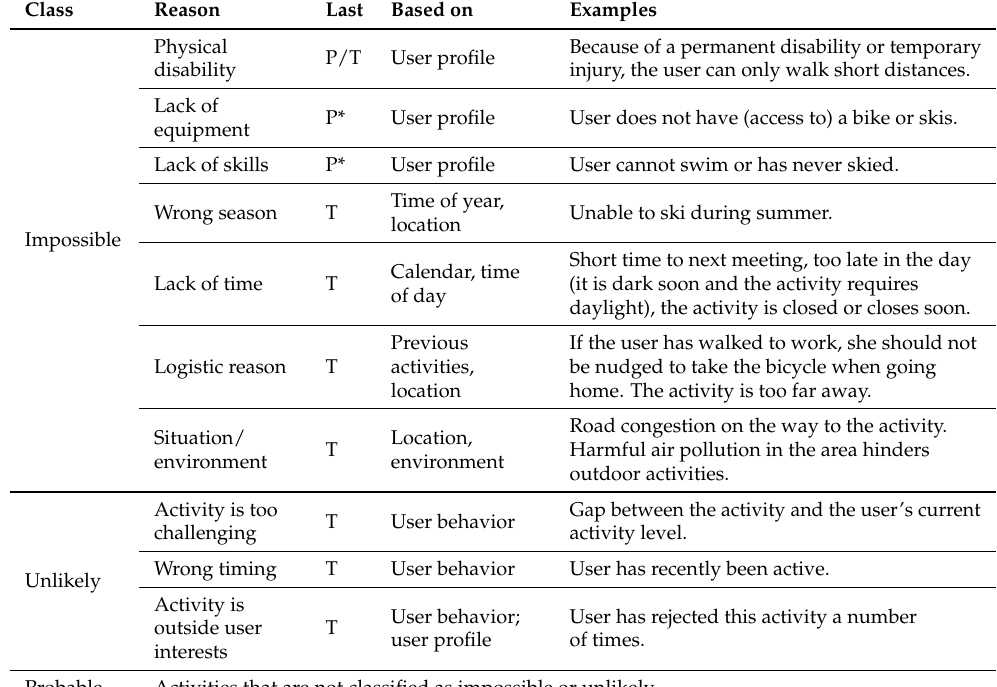
Table 2. Classification of